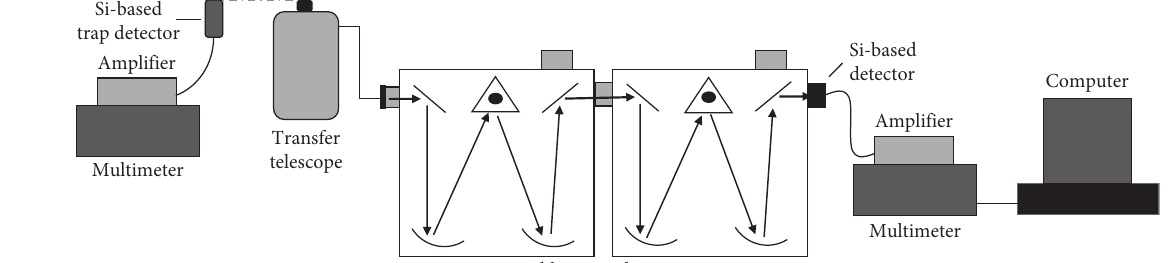
Figure 1: Spectral radiance measurement system.